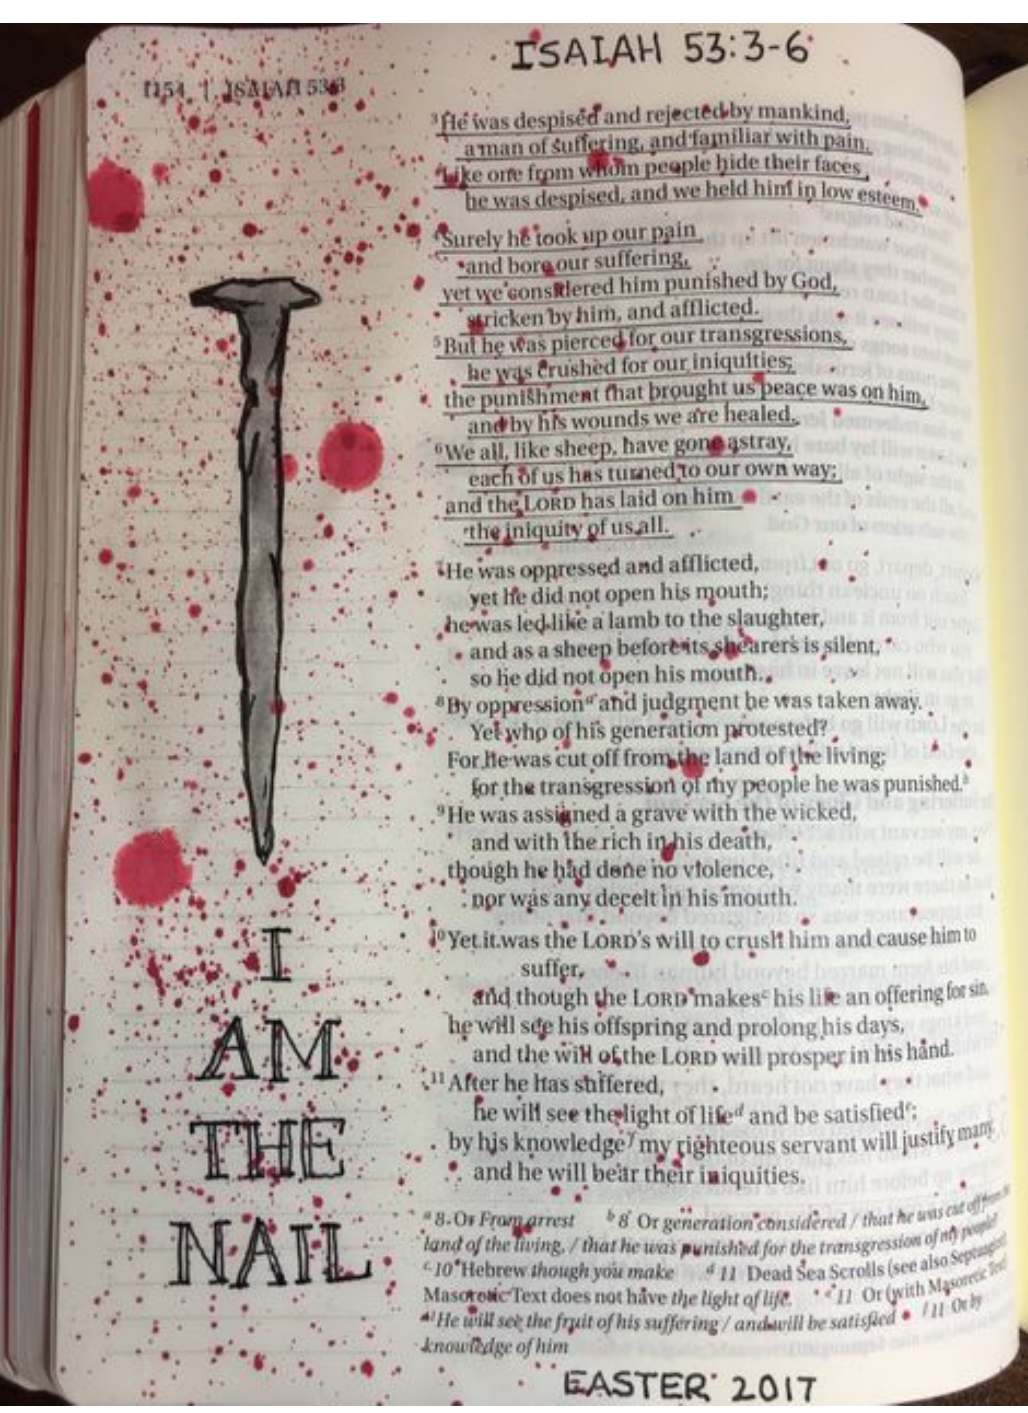
Figure 4. “ I AM THE NAIL ” (2004), Anonymous. Figure 5. “ I AM THE NAIL ” (2017),